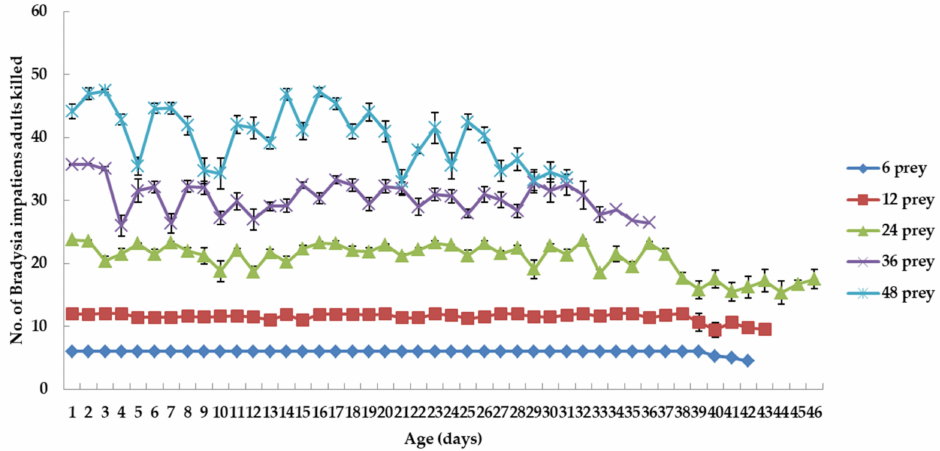
Figure 2. Mean number of prey killed per C. attenuata adult when fed 6, 12, 24, 36 and 48 adults of B. impatiens daily per predator adult (values are mean ± SE, single values were present when only one adult C. attenuata was left in the end).